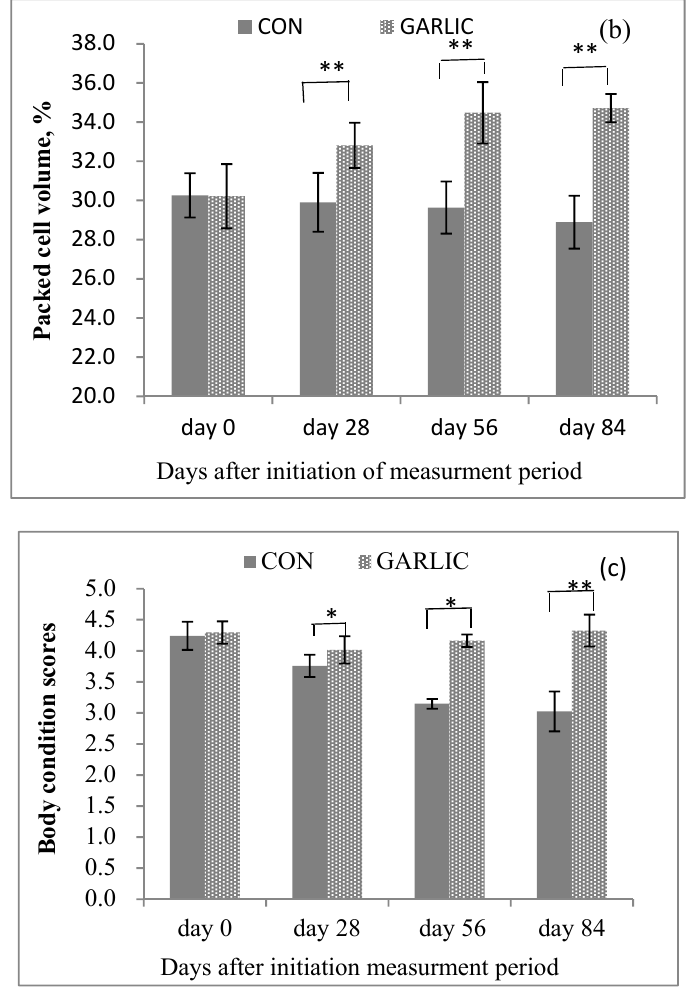
Figure 1. Fecal egg counts: ( a ) Packed cell volume, ( b ) body condition scores, and ( c ) (mean ± standard error) of lambs infected with gastrointestinal nematodes and fed with or without garlic powder. CON: Control treatment; GARLIC: Garlic powder supplemented treatment. *: p < 0.05; * *: p < 0.01.